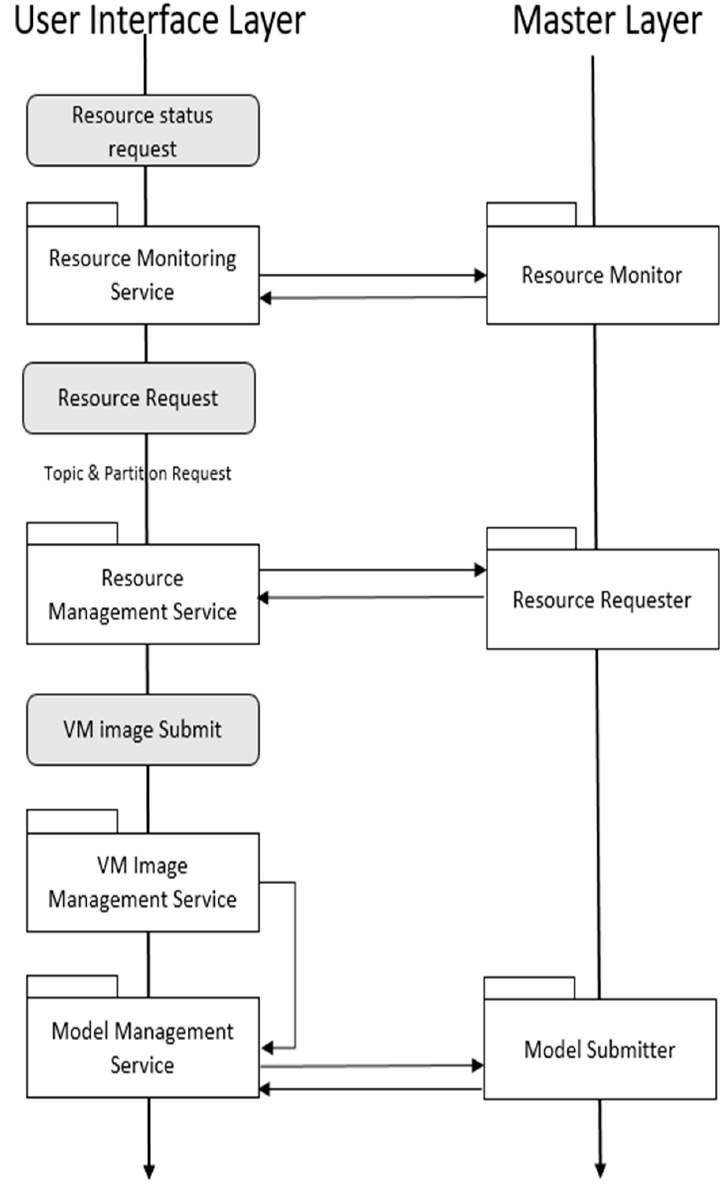
Figure 5. Module operation process on User Interface Layer.